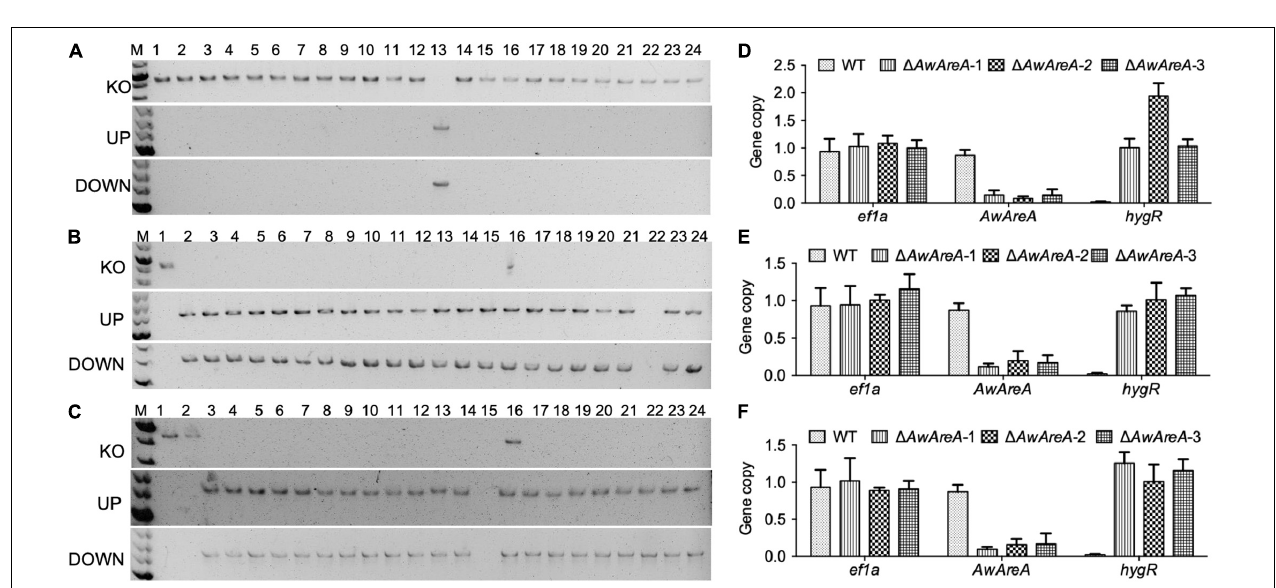
FIGURE 2 | Deletion of AwpyrG in Aspergillus westerdijkiae . (A) Strategy for AwpyrG deletion. (B) Fungal sensitivity test of A. westerdijkiae against 5-FOA. (C) PCR identification results of WT (1) and (cid:49) AwpyrG (2–4). The fragment KO was amplified with primer pair ko-F/ko-R, and the fragments OUT were amplified with primer pair out-F/out-R. (D) The growth status of WT and (cid:49) AwpyrG on PDA media with/without 5-FOA and UU for 8 days.